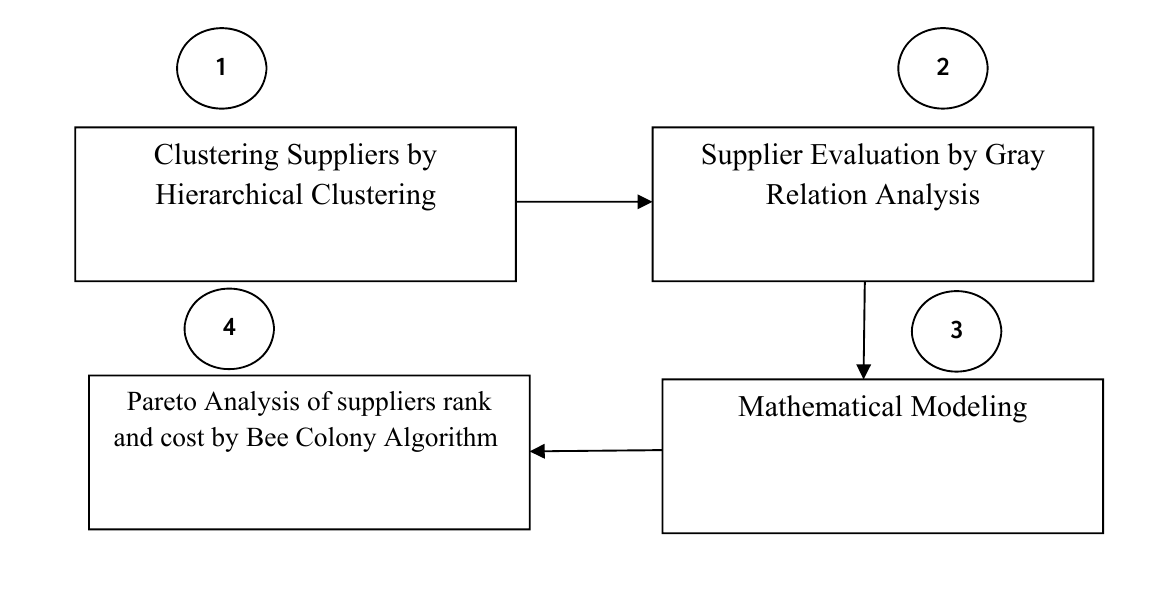
Fig. 2 A framework for supplier